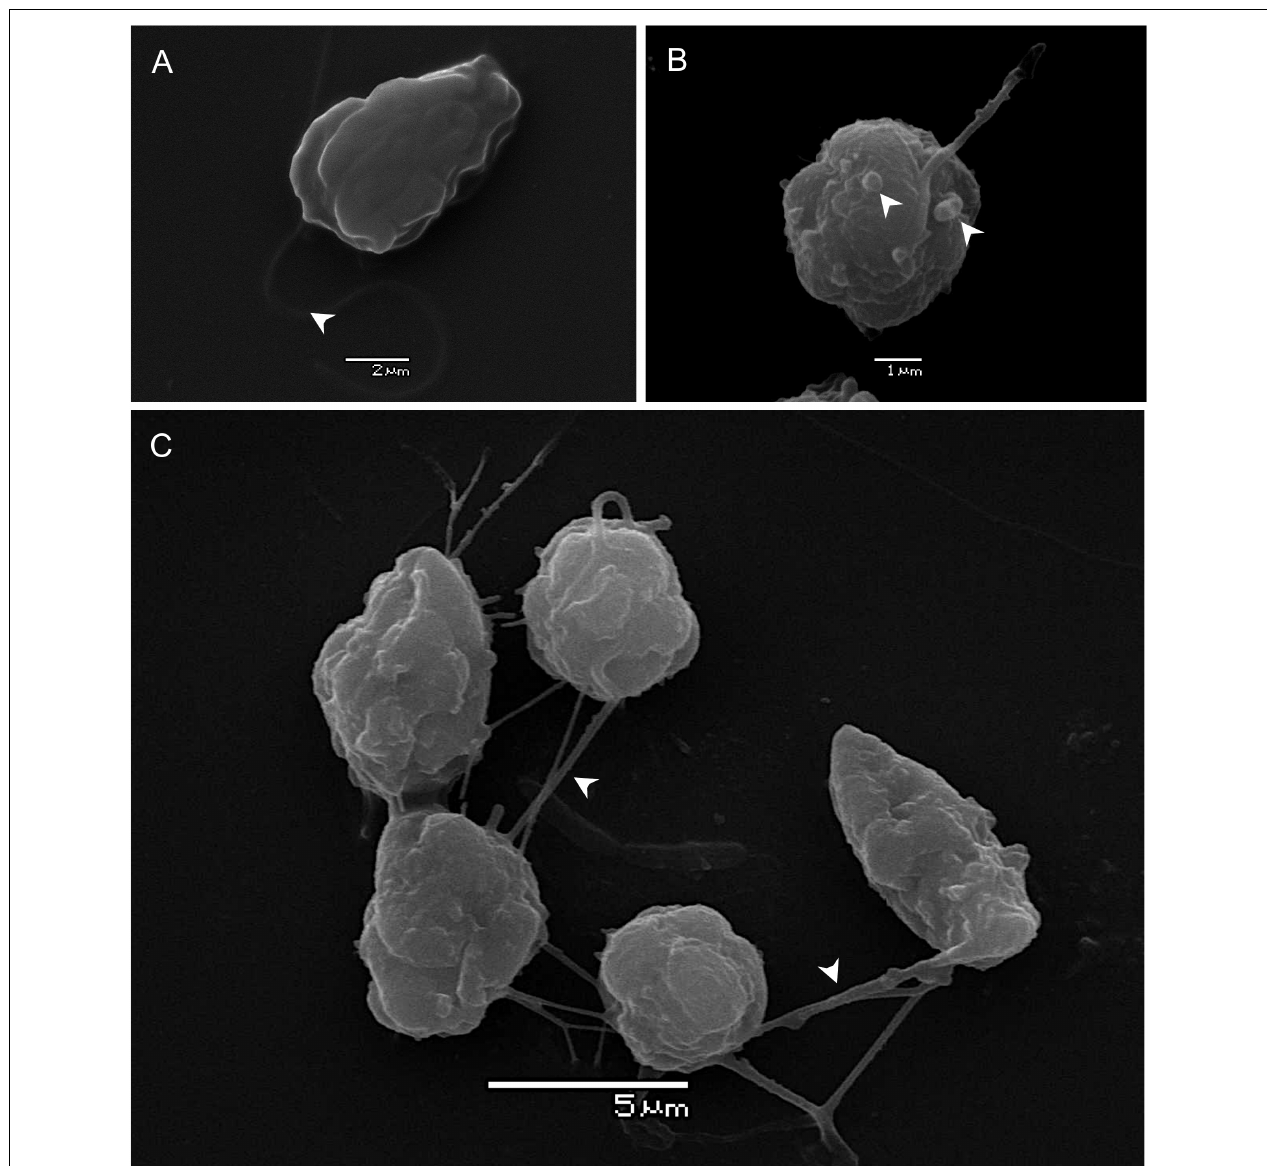
FIGURE 3 | Scanning electron microscopy of P. verruculosa ARC498 strain. (A) Ovoid cell with a long forwardly directed flagellum (arrowhead) from culture at 35 in salinity, (B) spherical cell with mucocysts at the periphery of the cell (arrowheads) from culture at 25 in salinity, and (C) group of cells interconnected by thin mucus-filaments